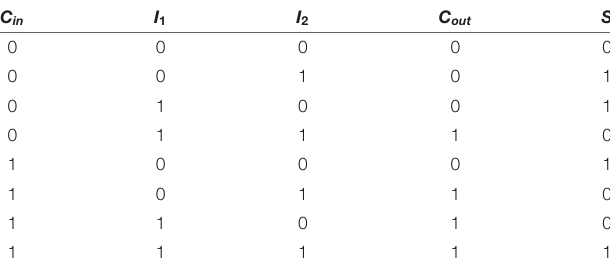
Figure 5D ; I 1 I ′ in Figure 5E ; I 1 in Figure 5F ; I ′ 2